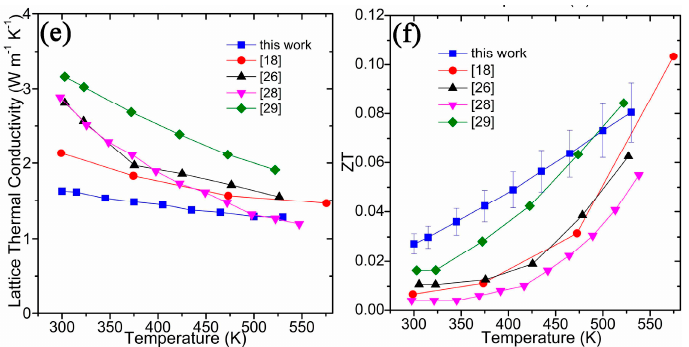
Figure 6. Thermoelectric properties of a SnTe pellet showing: ( a ) the electrical conductivity; ( b ) the Seebeck coefficient; ( c ) the power factor; ( d ) the thermal conductivity; ( e ) the lattice thermal conductivity and ( f ) ZT as a function of temperature, with comparisons with selected literature values for SnTe bulk materials synthesised by ball milling and high-temperature synthesis.